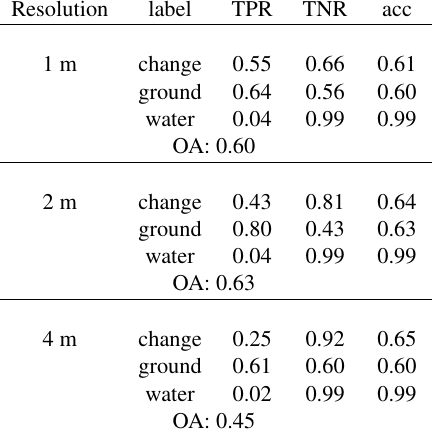
Figure 5. Overview of the semantic changes from the data of 2017, manually labeld.